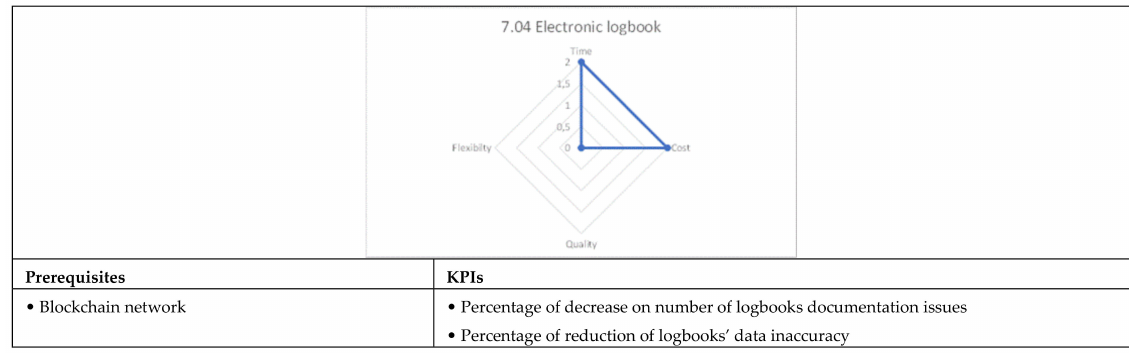
Figure A45. Electronic logbook data sheet.